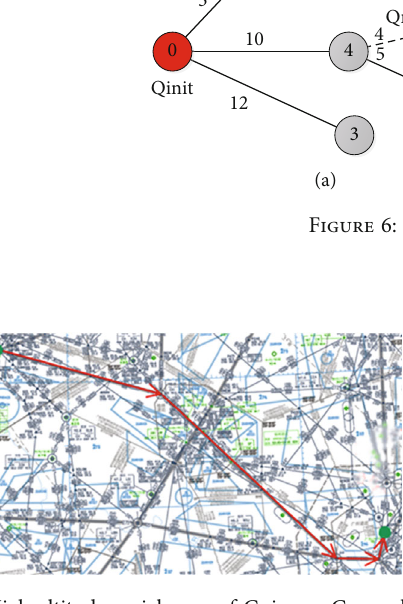
Figure 7: High-altitude aerial map of Guiyang – Guangzhou route in